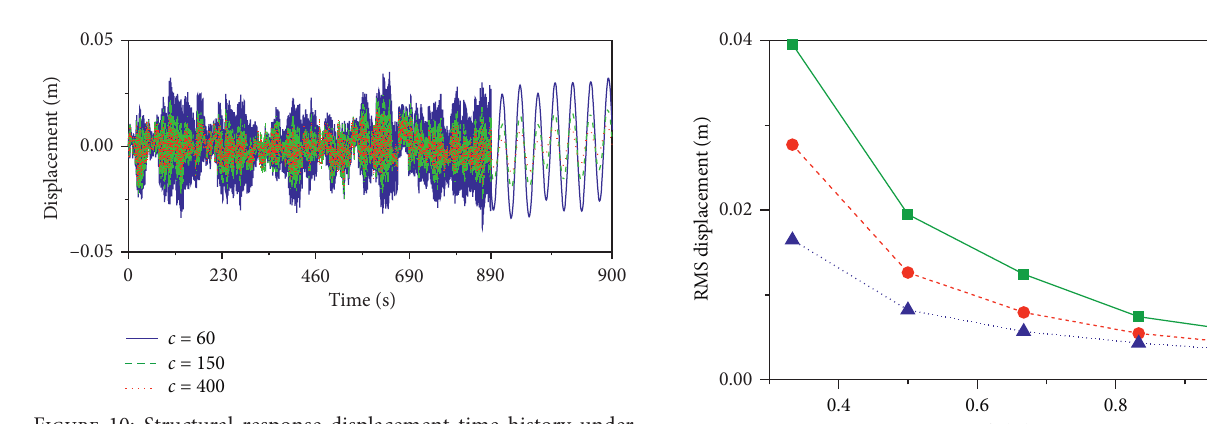
Figure 10: Structural response displacement time history under pulsating wind.